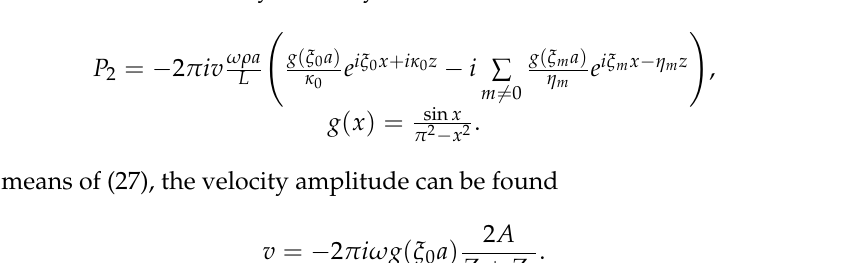
Figure 5. A surface with an array of membranes oscillating at the second eigenfrequency. The sound field radiated by the array is